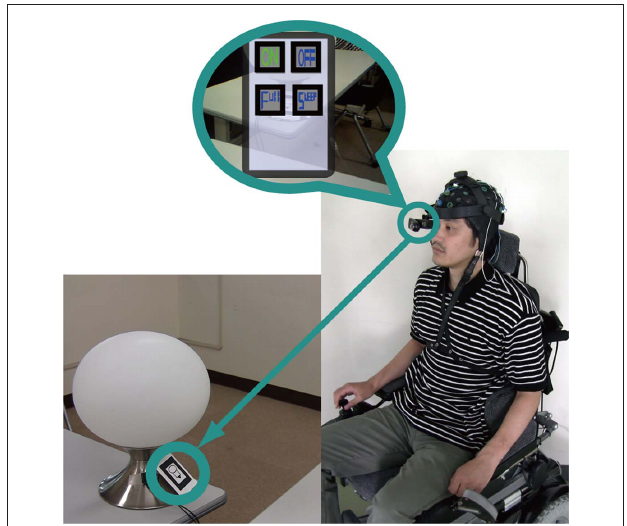
FIgure 1 | Diagram of the Ar–BMI system. When the USB camera detects an AR marker, the control panels for a pre-assigned appliance (e.g., desk light) are added to the user’s sight and the device becomes controllable. The subjects are able to operate the appliance by focusing on an icon on the augmented control panel.